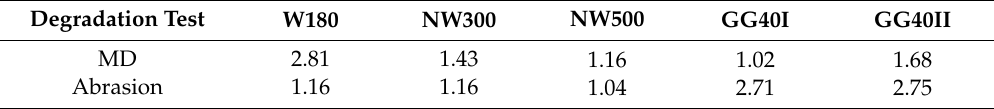
Table 6. Reduction factors obtained for the single exposures to the degradation